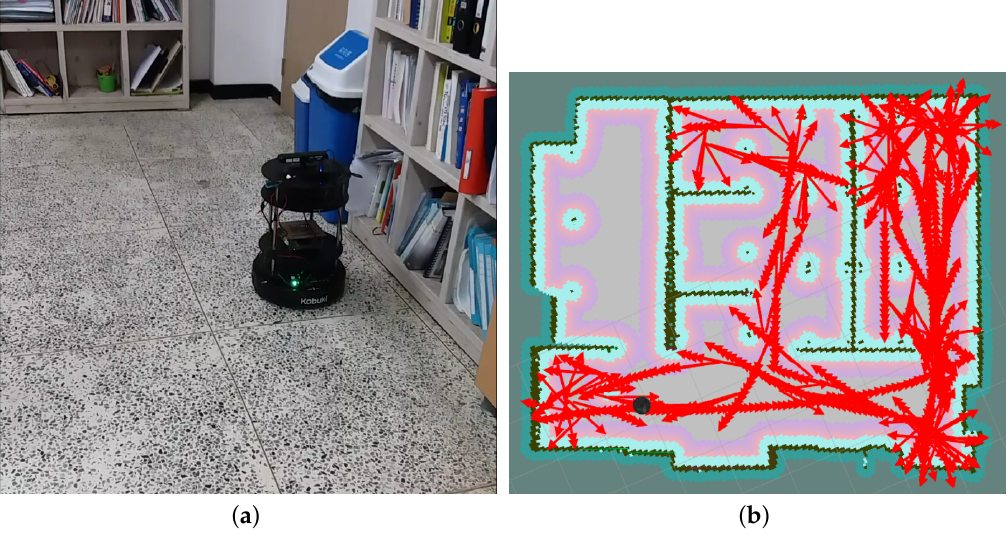
Figure 14. Real test result. ( a ) SLAM visualization of our real robot movement in Smart Autonomous System laboratory; ( b ) Our modified real robot in Smart Autonomous System